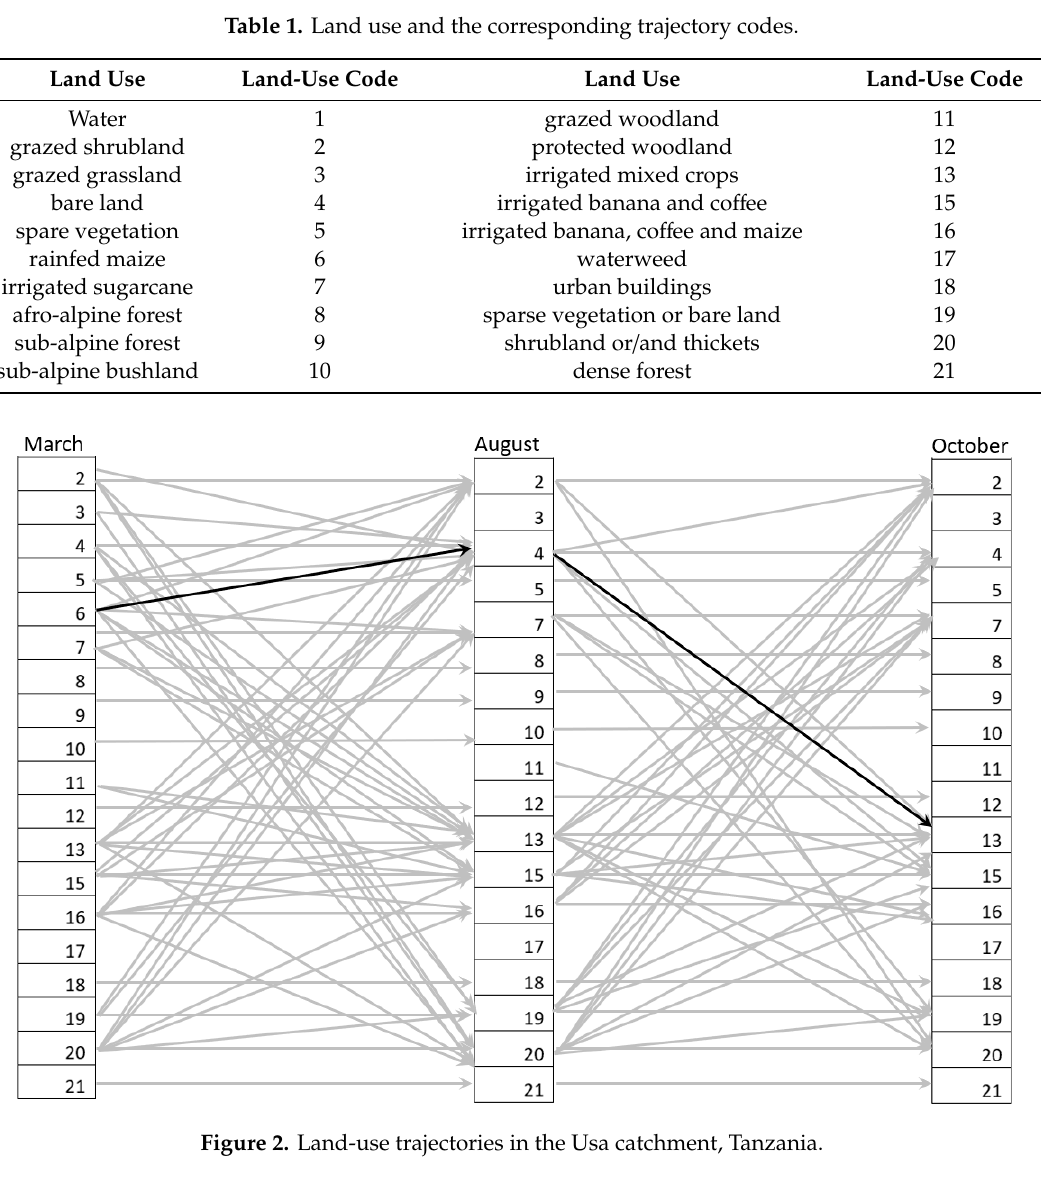
Figure 2. Land-use trajectories in the Usa catchment, Tanzania.